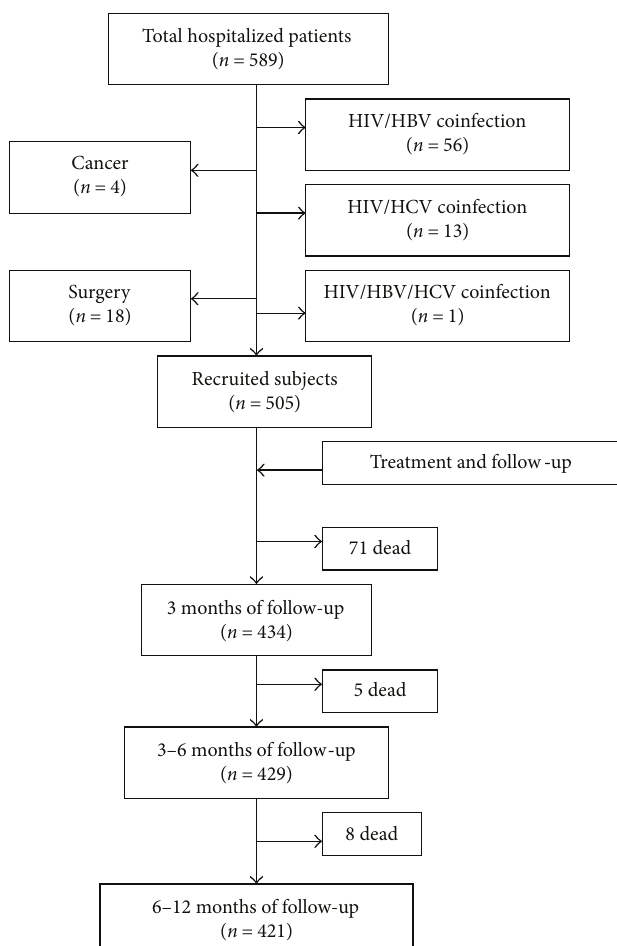
Figure 1: Study fl owchart for patient